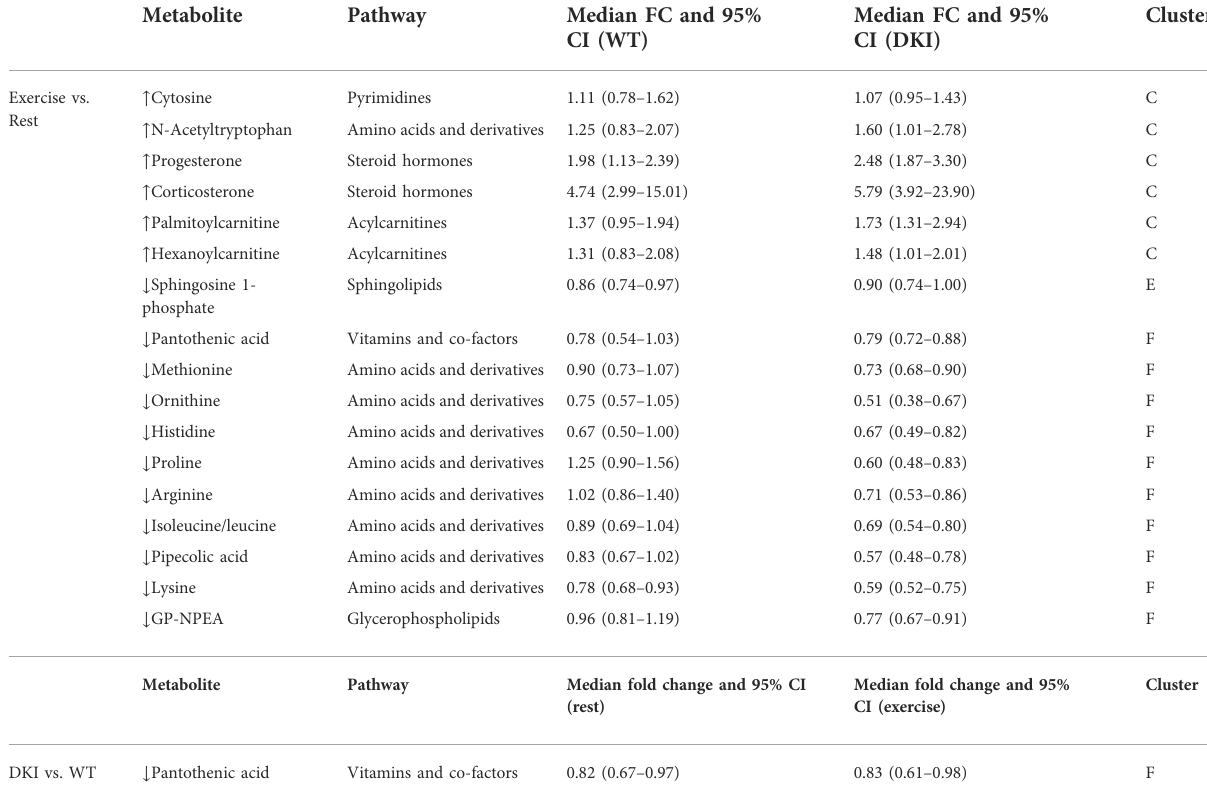
TABLE 2 Summary of the 17 metabolites signi fi cantly changed by exercise and/or genotype. A total of six metabolites signi fi cantly increased and 11 metabolites signi fi cantly decreased following exercise, at the univariate level. Increased metabolites primarily consisted of acylcarnitines and steroid hormones, while decreased metabolites predominantly consisted of amino acids and derivatives. Only pantothenic acid was signi fi cantly decreased in DKI versus WT mice at the univariate level. CI: con fi dence interval; FC: fold-change; ↑ : increase; ↓ :